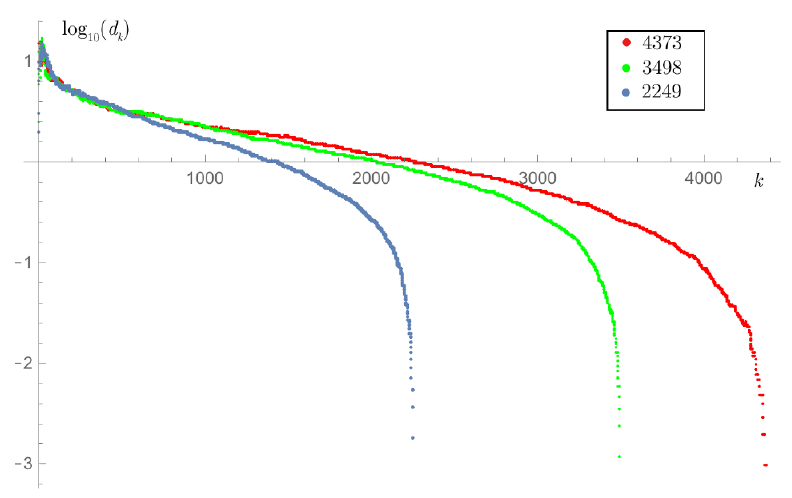
(cid:16) (cid:17) N out ( a k ) ( d k ) = log for each node a k in each layer k for three 10 10 N in ( a k +1 )